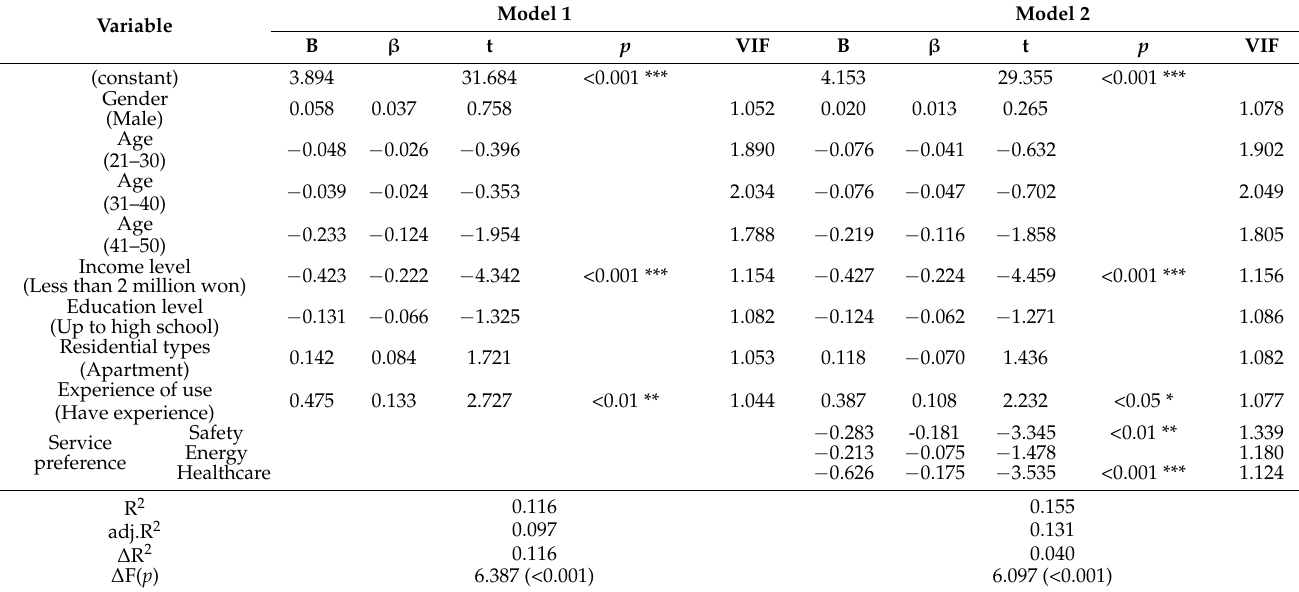
Table 6. The results of regression analysis (* p < 0.05, ** p <0.01, *** p <